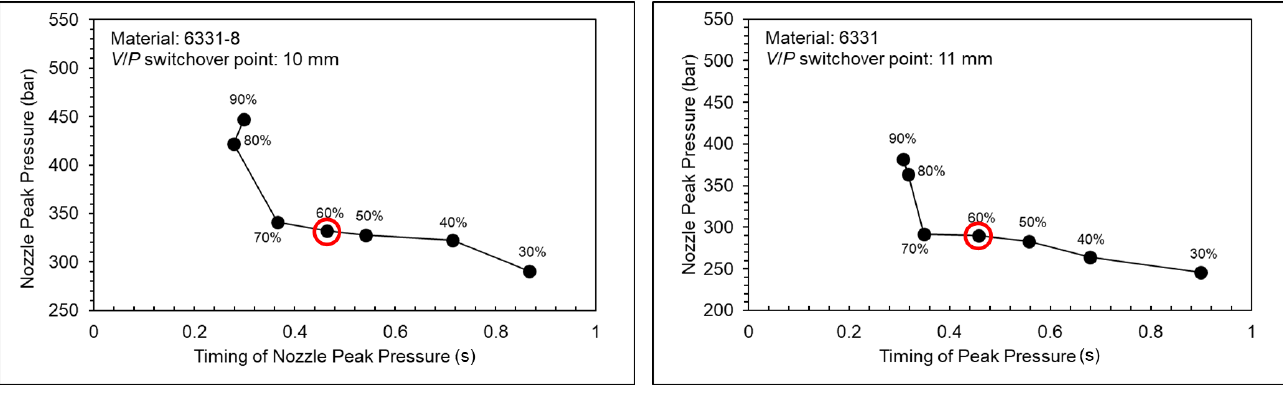
Figure 13. Nozzle pressure profile at different injection speeds (( a ) 6331 − 8, ( b ) 6331, and ( c ) PT231).